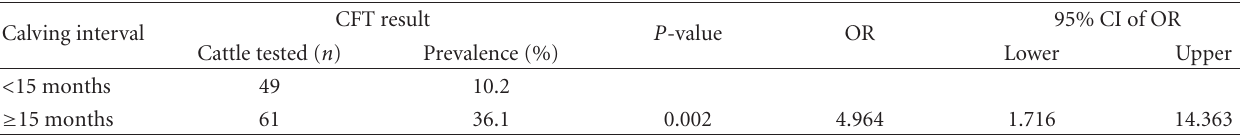
Table 4: Univariable logistic-regression (LR) analyses of reproductive performance parameter (calving interval in months) with dependent Brucella seropositivity in female cattle in Western Tigray, North West Ethiopia. OR:odds ration, CI:confidence interval, October 2007 to